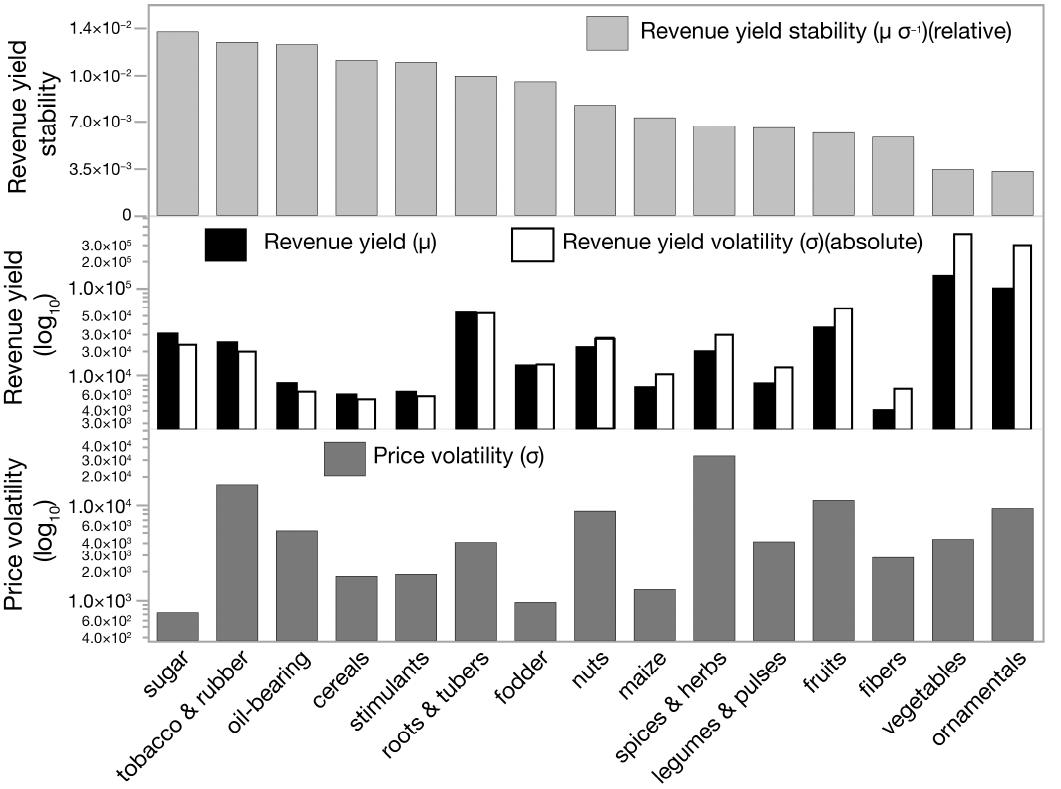
Figure 6. Price volatility ( σ P ), mean revenue ( µ ), absolute revenue volatility ( σ R ), and relative reve- nue stability ( μσ R − 1 ) of crop groups in the study area. Groups ordered by decreasing relative revenue stability.